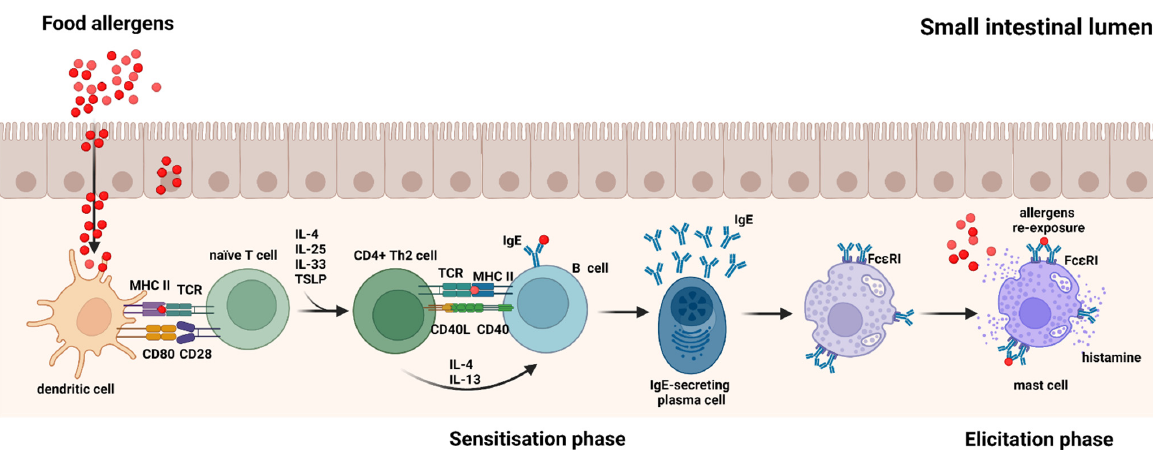
Figure 1. Mechanisms of IgE ‐ mediated food allergy. IgE ‐ mediated food allergy is divided into two phases: a sensitisation and an elicitation phase. In the sensitisation phase, food allergens are taken up by dendritic cells, which process allergens into smaller peptides and present them on MHC II molecules to T ‐ cell receptors (TCRs) on naïve T cells. T cells are activated upon ligation of CD28 on the surface of naïve T cells and CD80 on the surface of dendritic cells, with co ‐ stimulation from pro ‐ inflammatory cytokines IL ‐ 4, IL ‐ 25, IL ‐ 33, and TSLP. Activated and differentiated Th2 cells interact and activate naïve B cells through TCR and antigen bound to MHC II on naïve B cells as well as through ligation of CD40L on the surface of Th2 cells and CD40 on the surface of B cells, together with co ‐ stimulation from IL ‐ 4 and IL ‐ 13 for maturation and differentiation of B cells into food allergen ‐ specific IgE ‐ secreting plasma cells. Secreted food allergen ‐ specific IgEs bind to high ‐ affinity Fc ԑ RI receptors on tissue mast cells and/or blood basophils. In the elicitation phase, re ‐ exposure to the same or cross ‐ reactive food allergens causes allergen cross ‐ linking of Fc ԑ RI ‐ bound specific IgEs on the surface of tissue mast cells and/or blood basophils leading to their degranulation and release of mediators, such as histamine. Graphics created with BioRender.com.